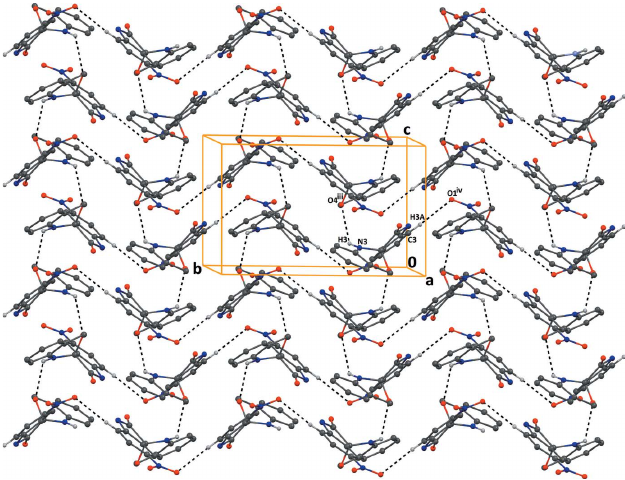
Figure 2 The crystal packing, viewed parallel to the bc plane, showing the